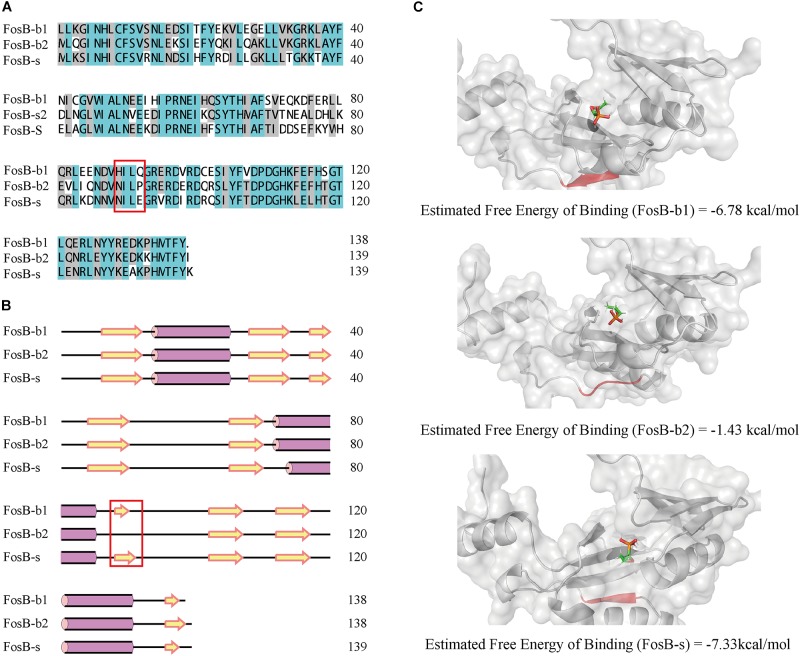
Comparative characterization of FosB-b1, FosB-b2, and FosB-s. (A) Multiple sequence alignment of FosB-b1, FosB-b2, and FosB-s. Different background colors indicated different sequences identity range. Malachite green, sequences identity = 100%; Gray, sequences identity > 50%; White, sequences identity < 50%. (B) The secondary structures prediction. The α-helix and β-strand were marked by the purple pillar and yellow arrow. (C) Molecular docking result structures of FosB-b1, FosB-b2 and FosB-s with fosfomycin. The residues and area of different β-sheet have been marked with red frame on sequences and secondary structures, and used red color to highlight them on the 3D structures.